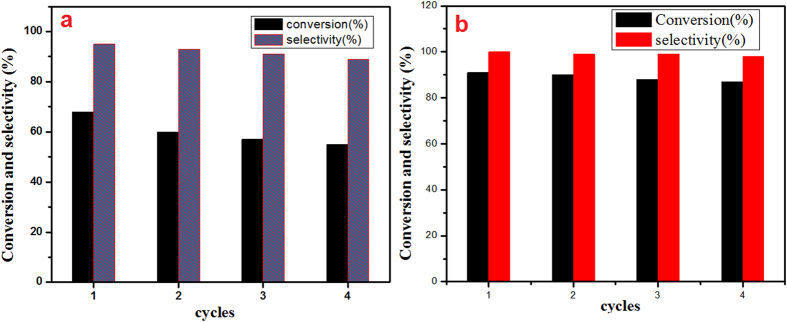
(a) Reusability studies of MCM prepared CeO2 NPs and (b) CRSGM prepared CeO2 NPs.